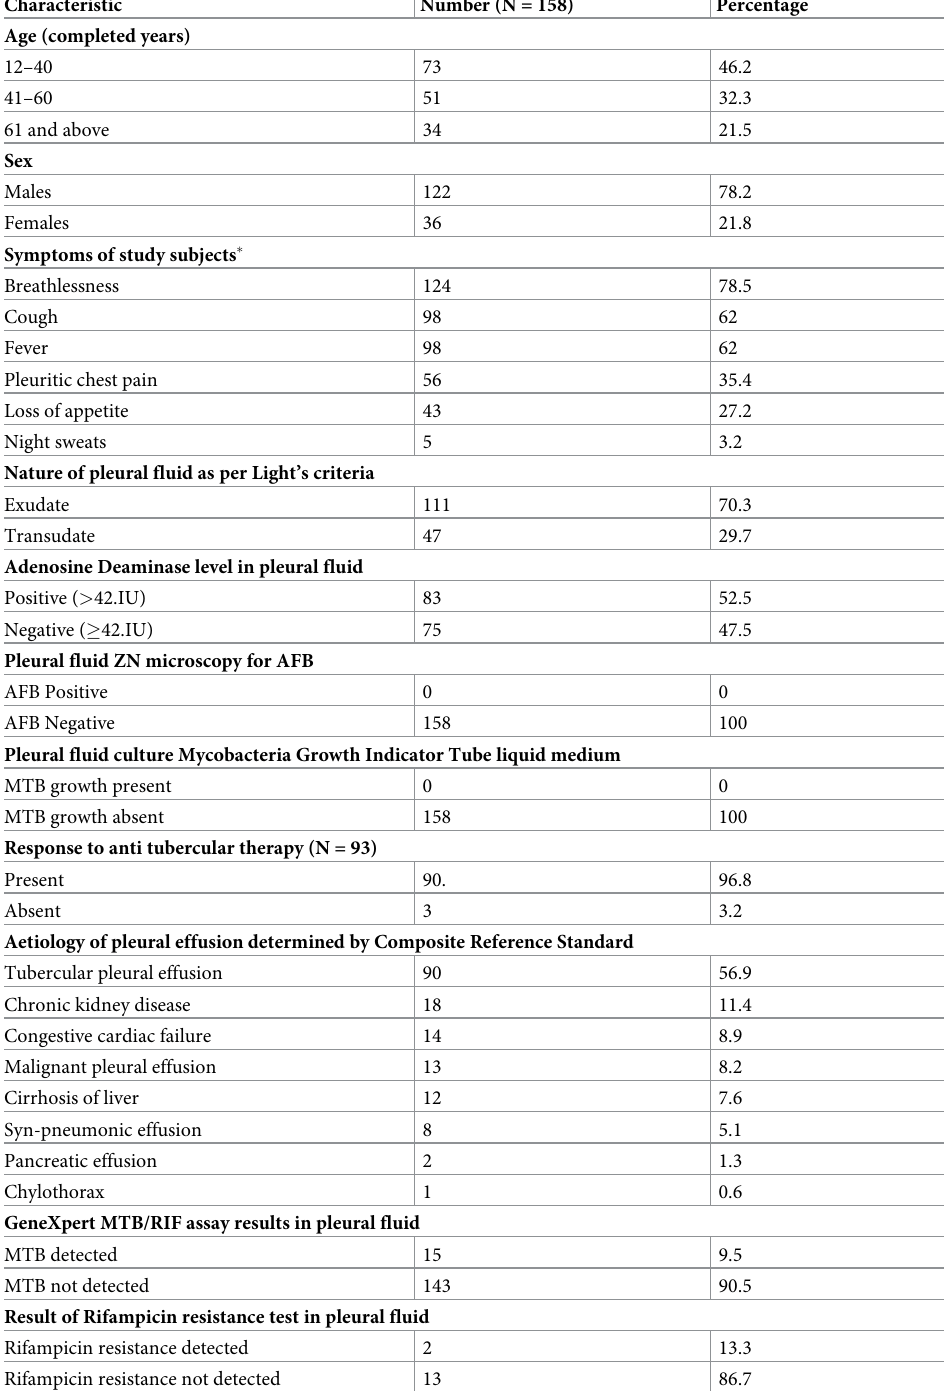
Table 1. Demographical, biochemical, microbiological, clinical characteristics of study subjects along with Gen- eXpert MTB/RIF assay